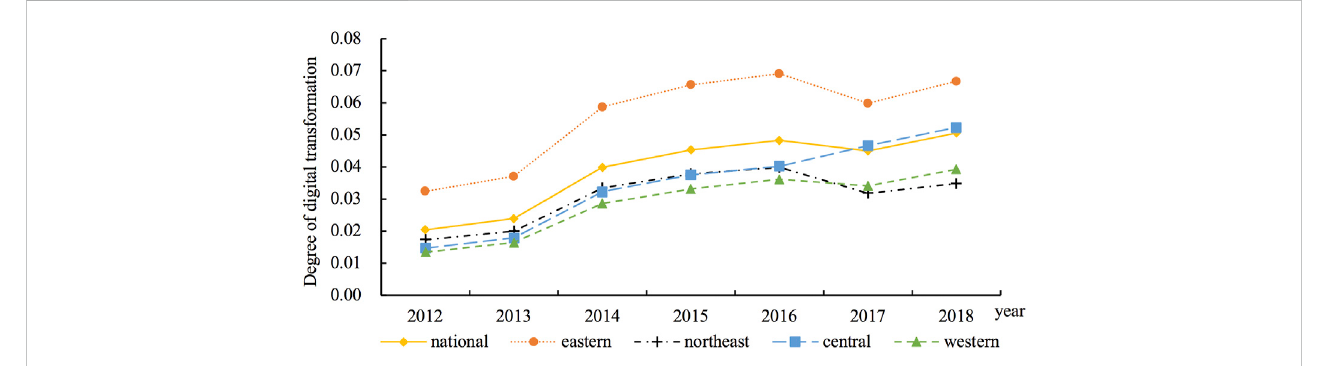
FIGURE 2 Evolution trend of average degree of digital transformation of manufacturing industry in china and four